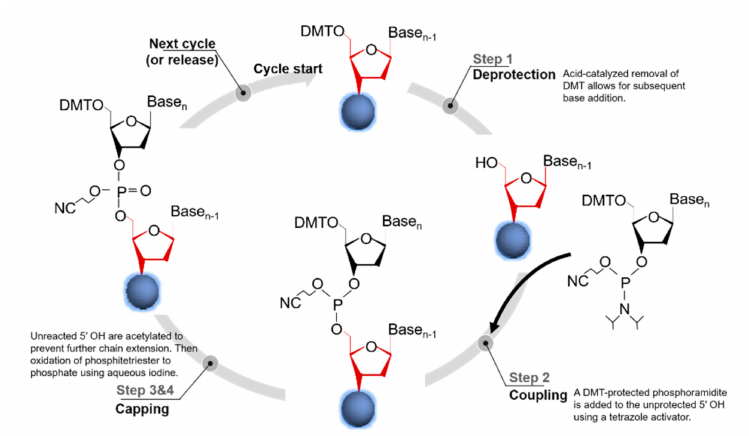
Figure 1. Phosphoramidite-based oligonucleotide synthesis